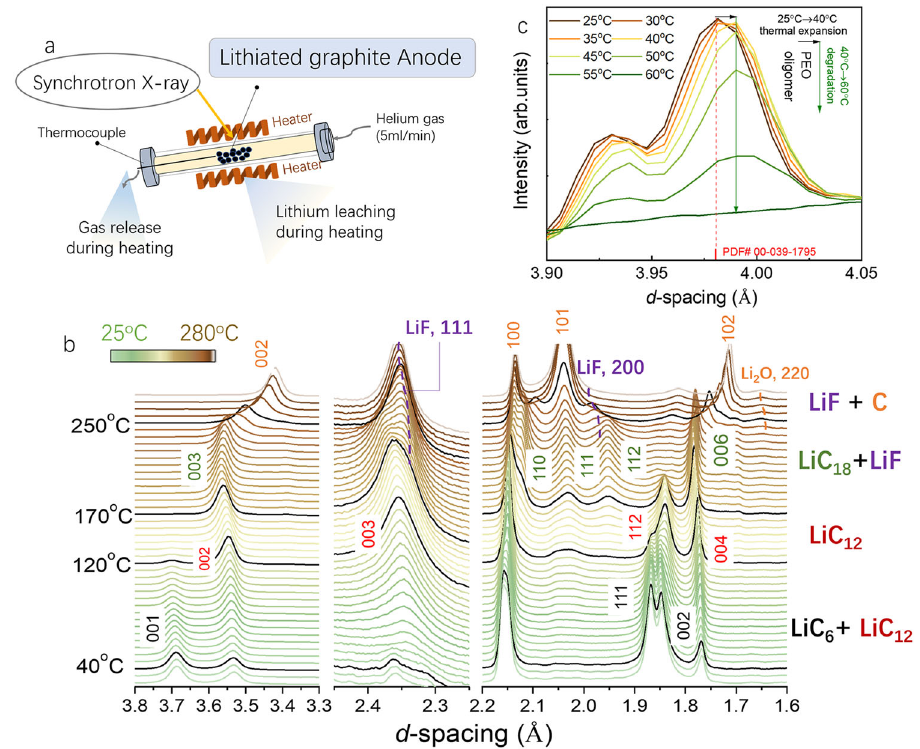
Fig. 1 The structural evolution of lithiated graphite during the heating process. a The scheme of the in situ experimental setup. b The waterfall plots of lithiated graphite anode during heating from 25 to 280 °C with 2 °C/min. The 2 θ value has been converted into d -spacing following Bragg ’ s rule for a better comparison to the results using different X-ray sources. c The polyethylene oxide (PEO) oligomer lattice expansion between 25 and 40 °C, with a coef fi cient of thermal expansion (CTE) of 167 × 10 − 6 °C, then PEO degradation during 40 – 60